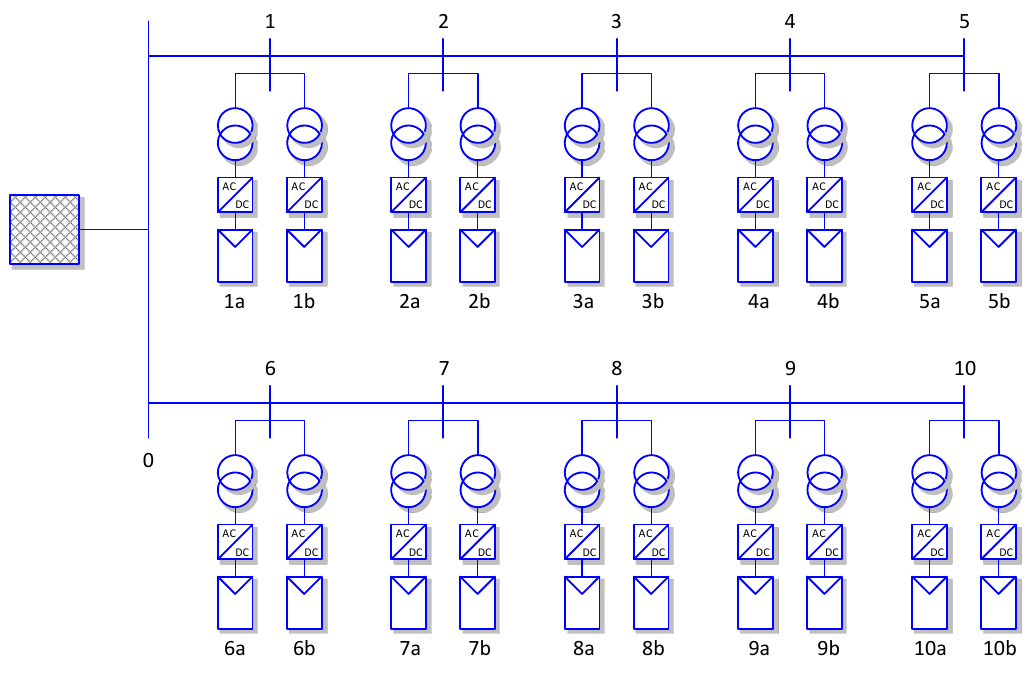
Figure 1. A photovoltaic (PV) power plant connected to a 33-kV grid.